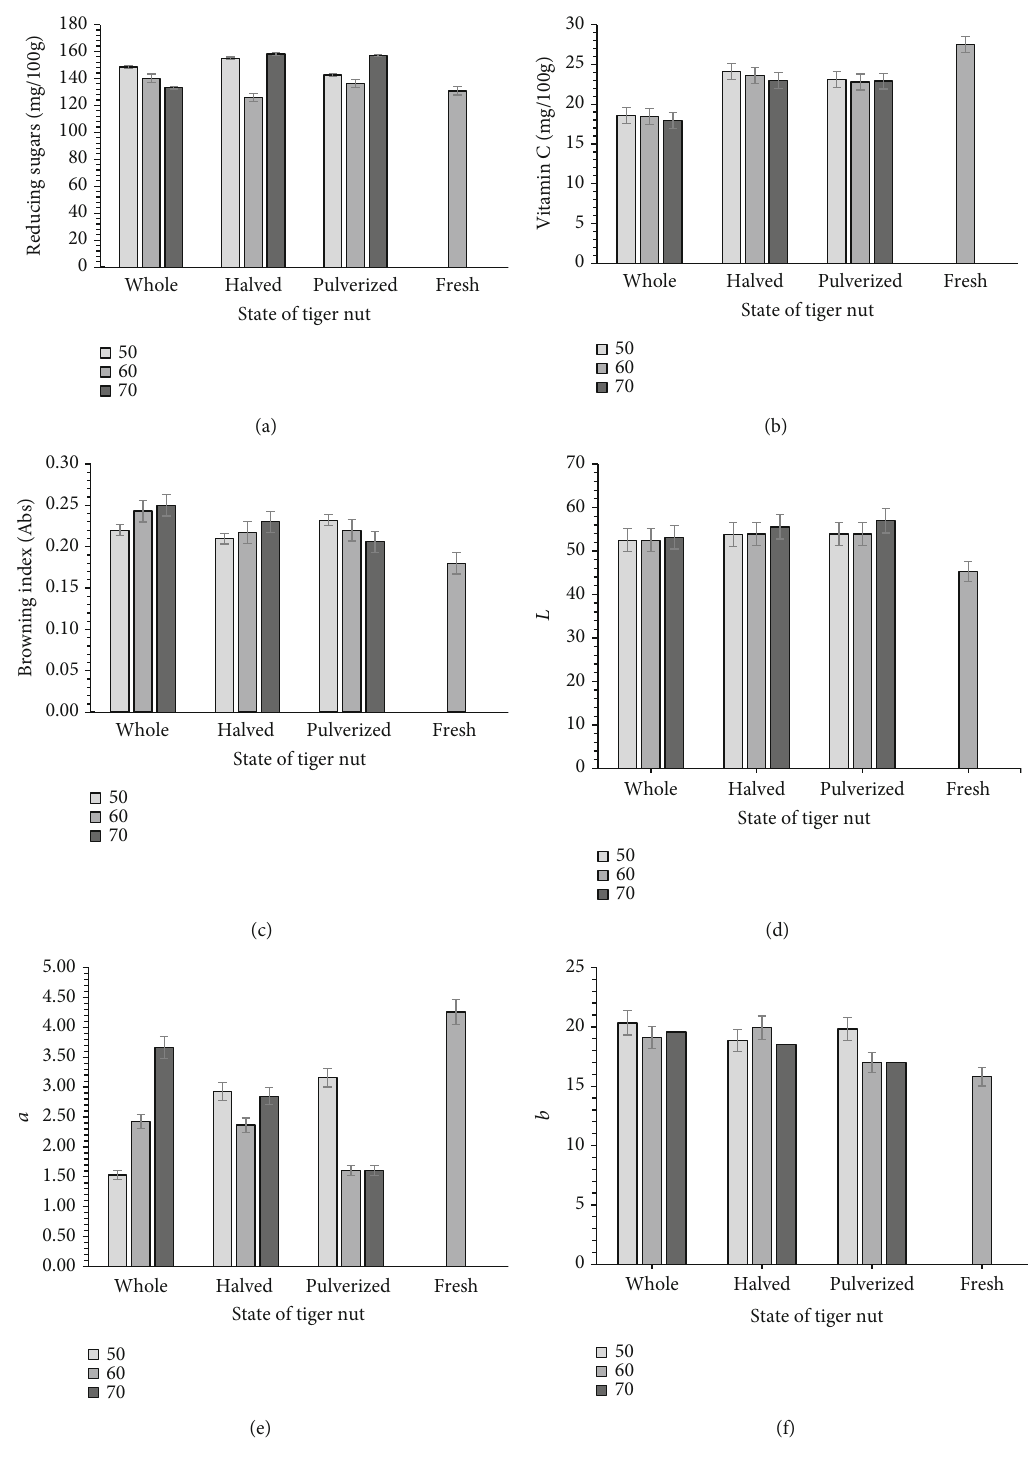
Figure 5: E ff ect of drying conditions on tiger nut